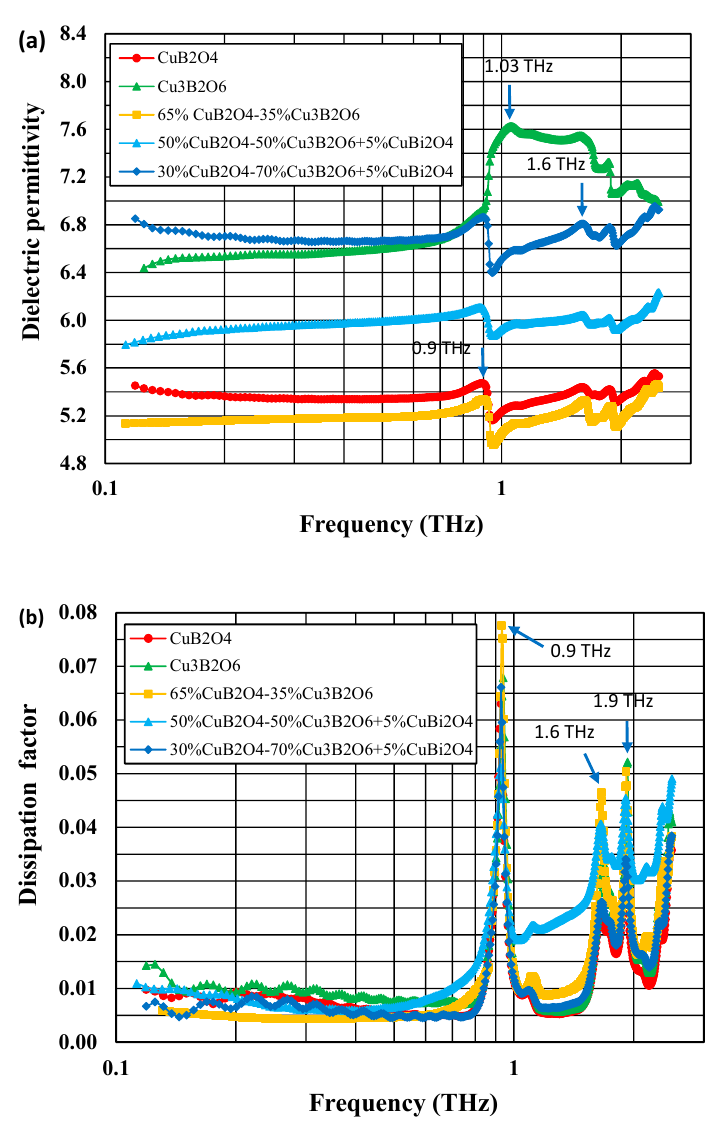
Figure 4. Comparison of dielectric permittivity ( a ) and dissipation factor ( b ) at 20 ◦ C as a function of frequency in the range 0.12–2.5 THz for CuB 2 O 4 , Cu 3 B 2 O 6 , and CuB 2 O 4 –Cu 3 B 2 O 6